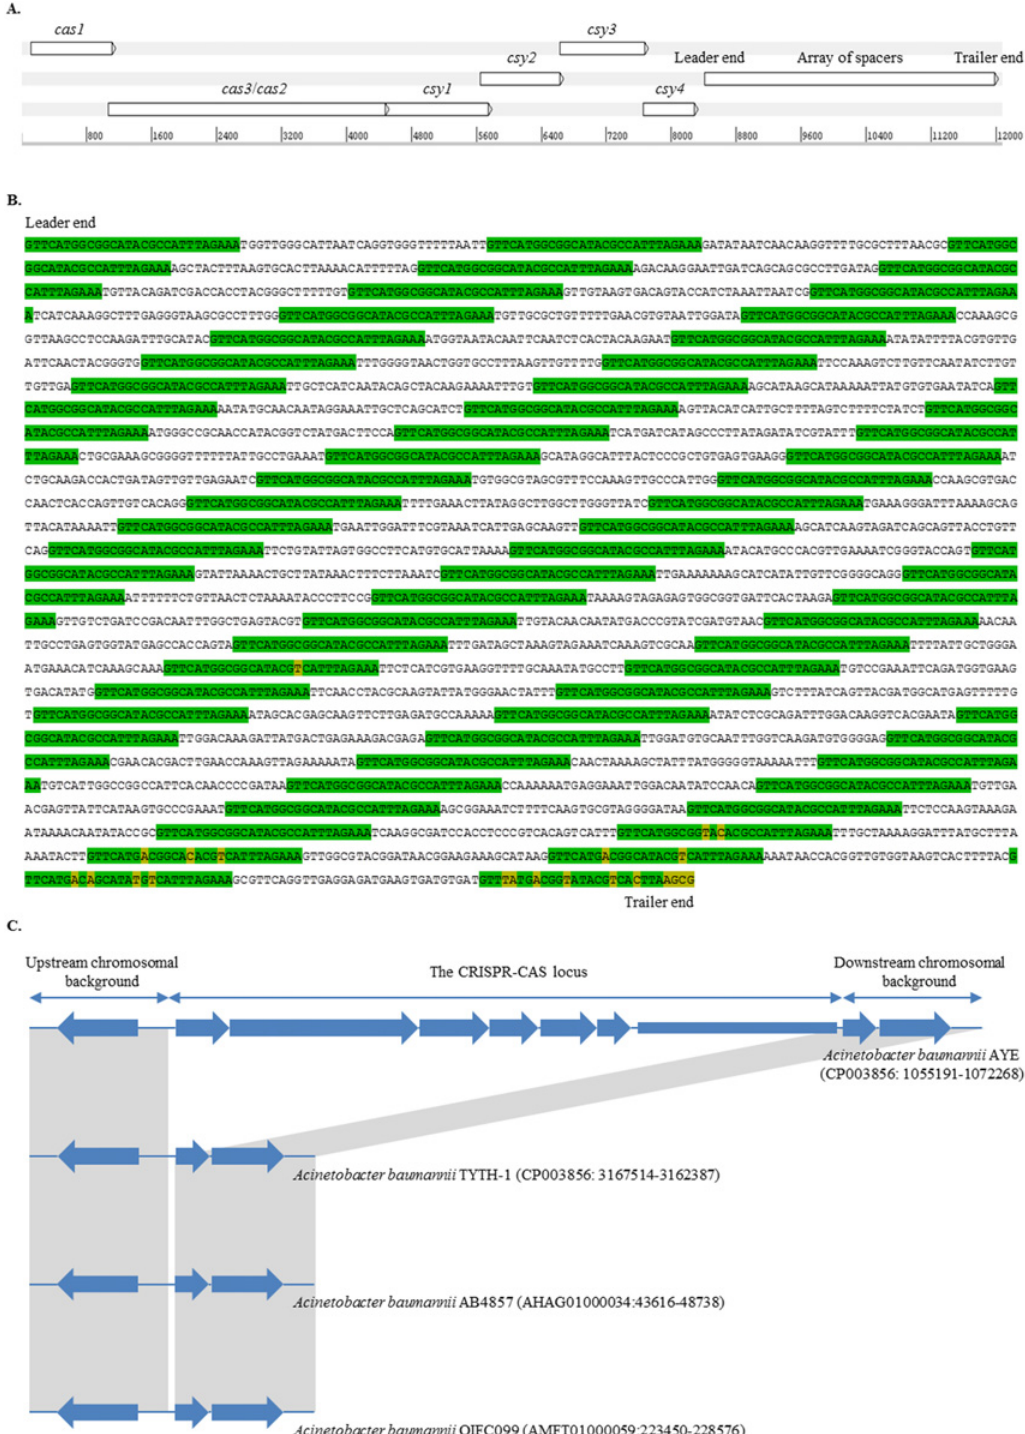
Fig 1. Genetic structure of the CRISPR- cas subtype I-Fb locus in Acinetobacter baumannii . A) The CRISPR- cas subtype I-Fb locus in A . baumannii strain AYE (GenBank accession number: CU459141, located at position 1,057,691 to 1,069,768). The locus consisted of two CRISPR – associated genes ( cas1 and cas3 / cas2 ), four Cas system-associated genes ( csy1 , csy2 , csy3 , and csy4 ), and an array of spacers. The map was created using Artemis (http:// www.sanger.ac.uk/resources/software/artemis/). B) Nucleotide sequence of the array of spacers in A . baumannii strain AYE. The array included 59 spacers surrounded by 60 direct repeats (marked in green). Some repeats, mainly at the trailer end of the array, included degenerated nucleotides (marked in yellow).